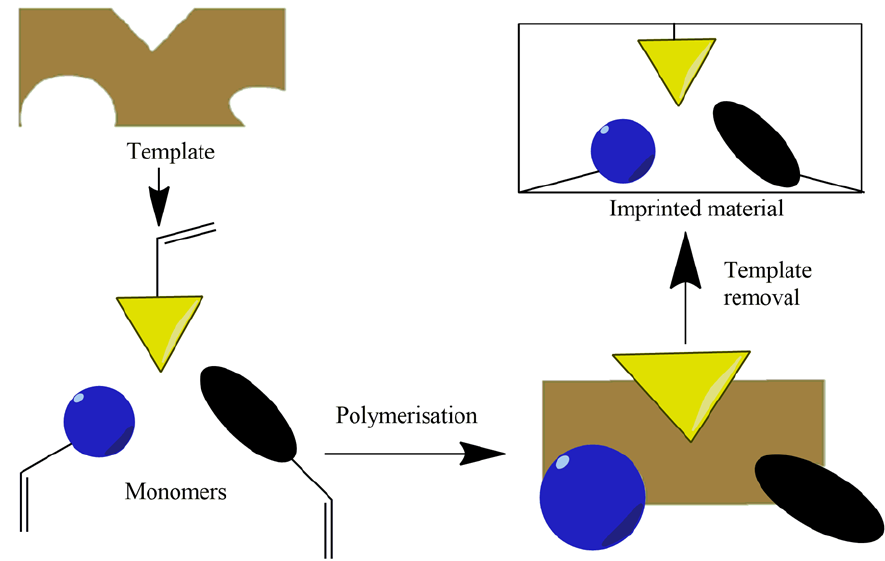
Figure 1. Synthesis of molecularly imprinted polymers (MIPs).